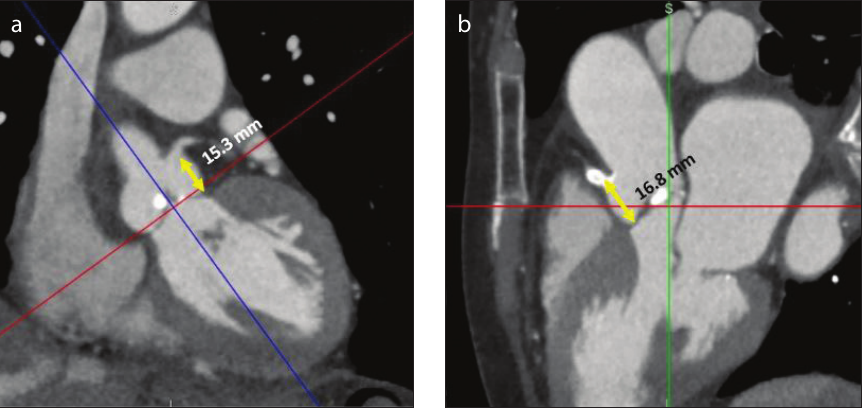
Figure 7. a, b. a) Distance between the aortic annulus and the origin of the left main coronary artery. b) Distance between the aortic annulus and the origin the right coronary